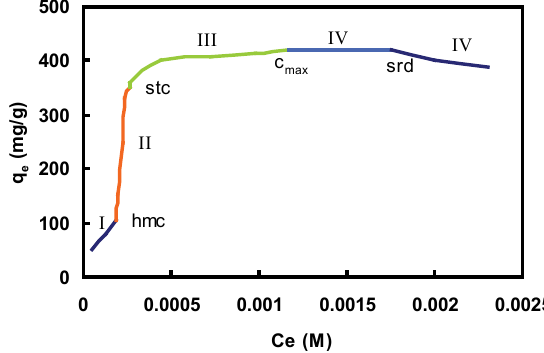
Figure 1. Schematic four-region adsorption isotherm according to the ARIAN